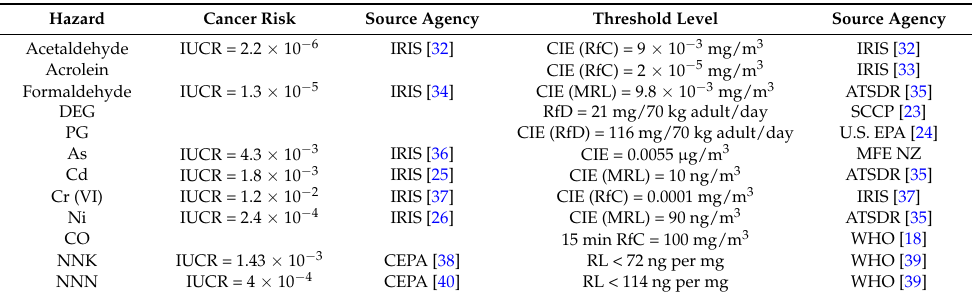
Table 1. Findings from the dose-response assessment for the major toxicants in electronic cigarettes (ECs) or conventional cigarettes